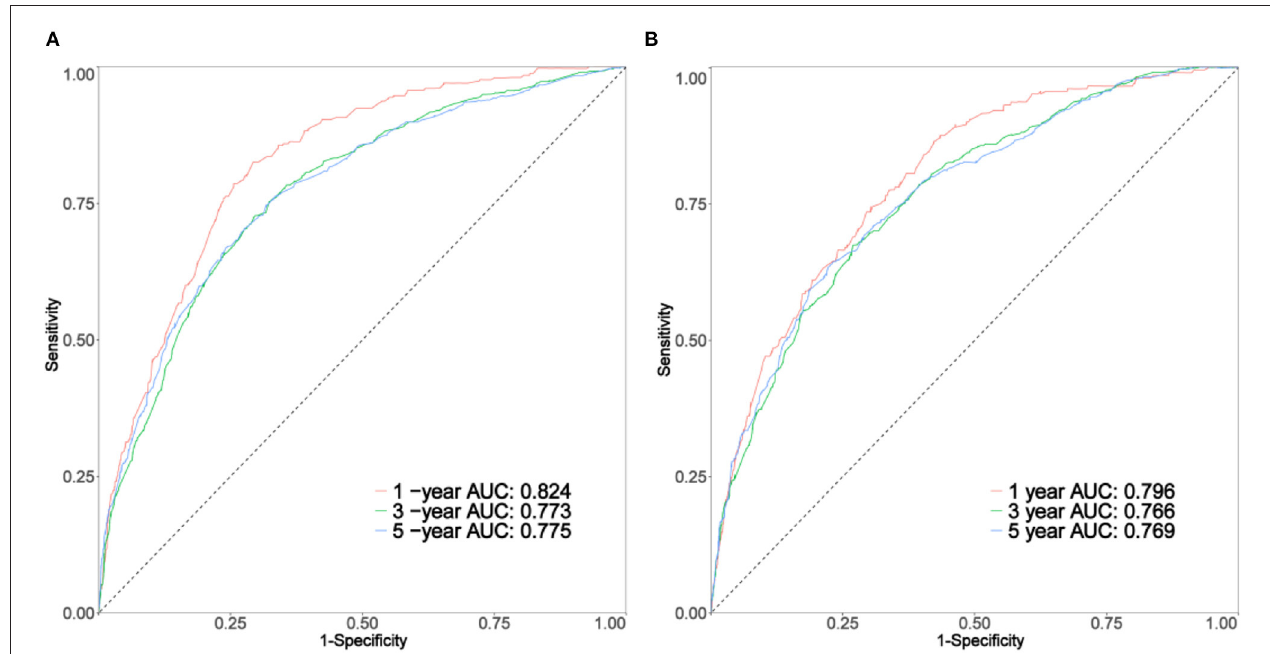
FIGURE 3 | The curve of (A,B) represents the receiver operating characteristic (ROC) of 1, 3, and 5 years of the training set and validation set,